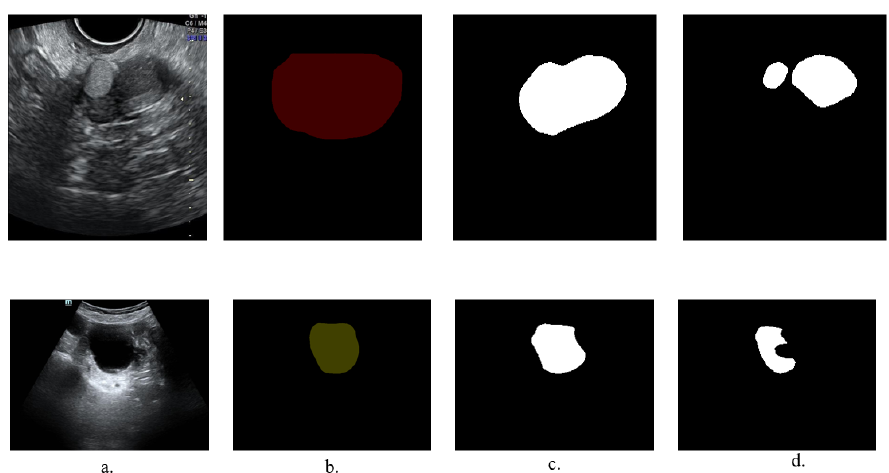
Figure 10. Visualization of the results of lesion segmentation of Unet. ( a ) The clean image. ( b ) The ground truth image. ( c ) Segmentation result of the Unet model using the inpainting images as the training set. ( d ) Segmentation result of the Unet model using the original images as the training